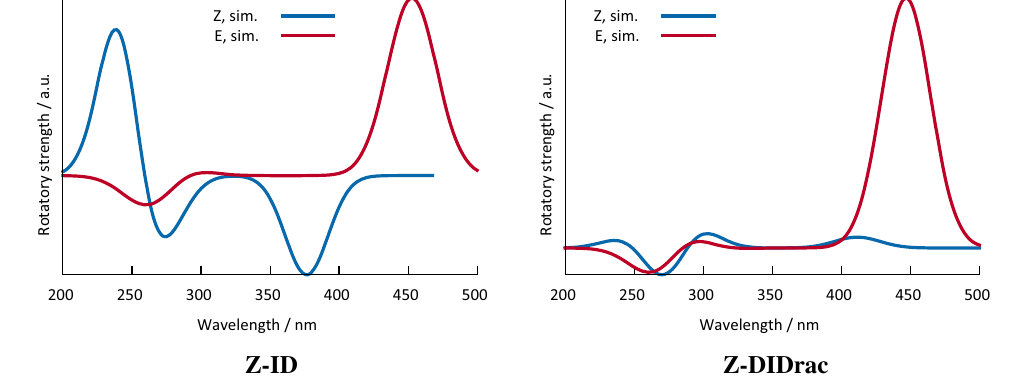
Figure 4. Simulated RI-CC2 CD spectra (unshifted) of Z-ID and Z-DIDrac